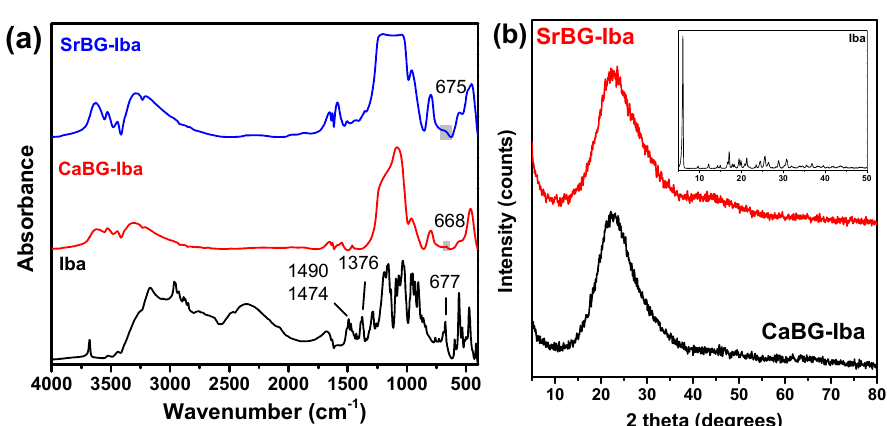
Figure 8. ( a ) FT-IR spectra of CaBG-Iba and SrBG-Iba and ( b ) X-ray diffraction patterns of Iba, CaBG-Iba and SrBG-Iba.